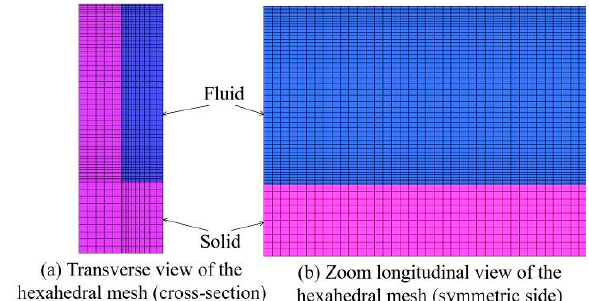
Figure 2. The discretized hexahedral meshes of the simulation domain of both fluid and solid regions.